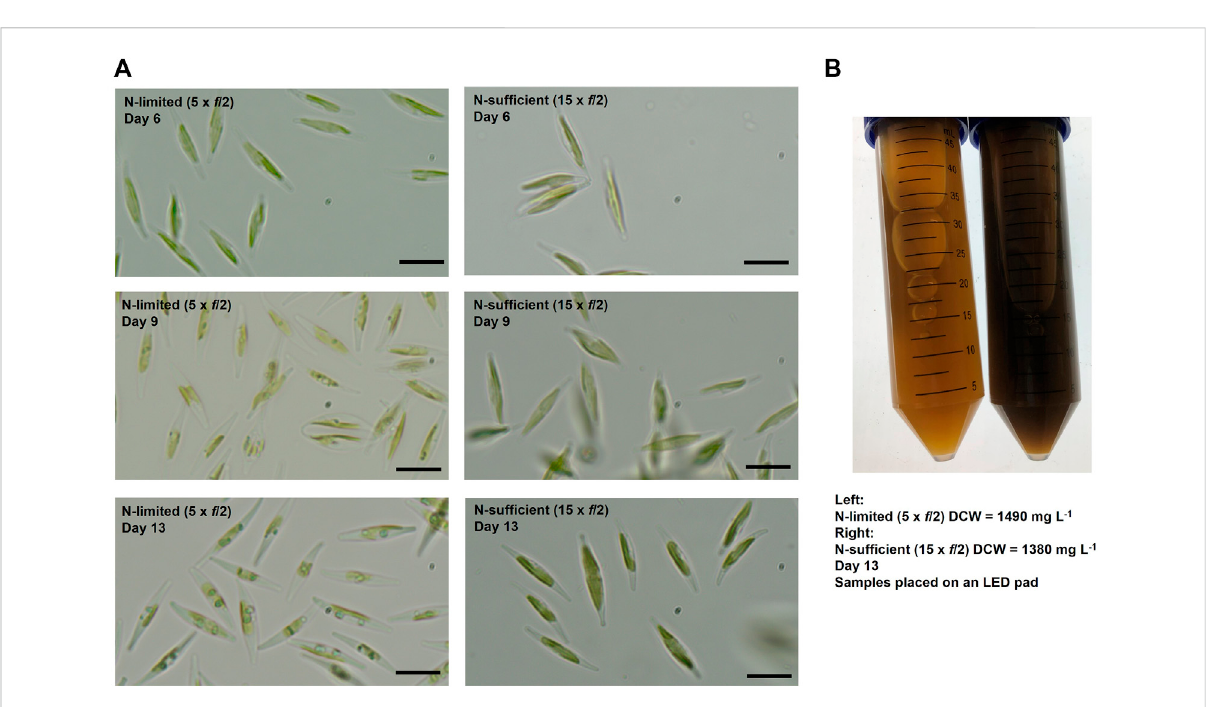
FIGURE 3 Changes in cell pigmentations over time (A) and comparison of samples collected on Day 13 (B) for batch cultures of P. tricornutum grown in nitrogen-limited (5 × f /2) and nitrogen-suf fi cient (15 × f /2) conditions. Scale bars represent 10 μ